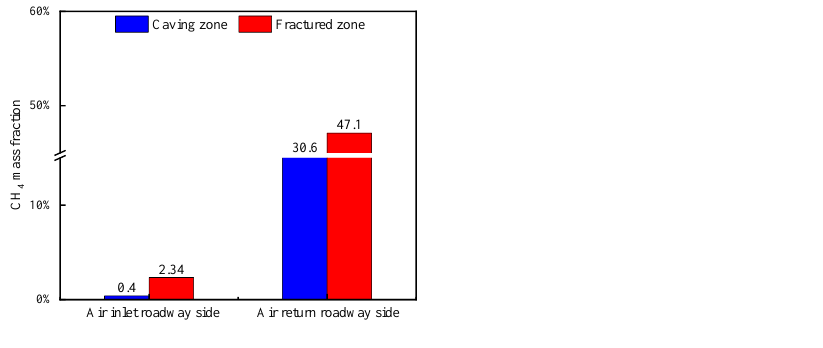
Figure 9. Comparison of gas mass fraction in the caving zone and fracture zone in the inclination direction.